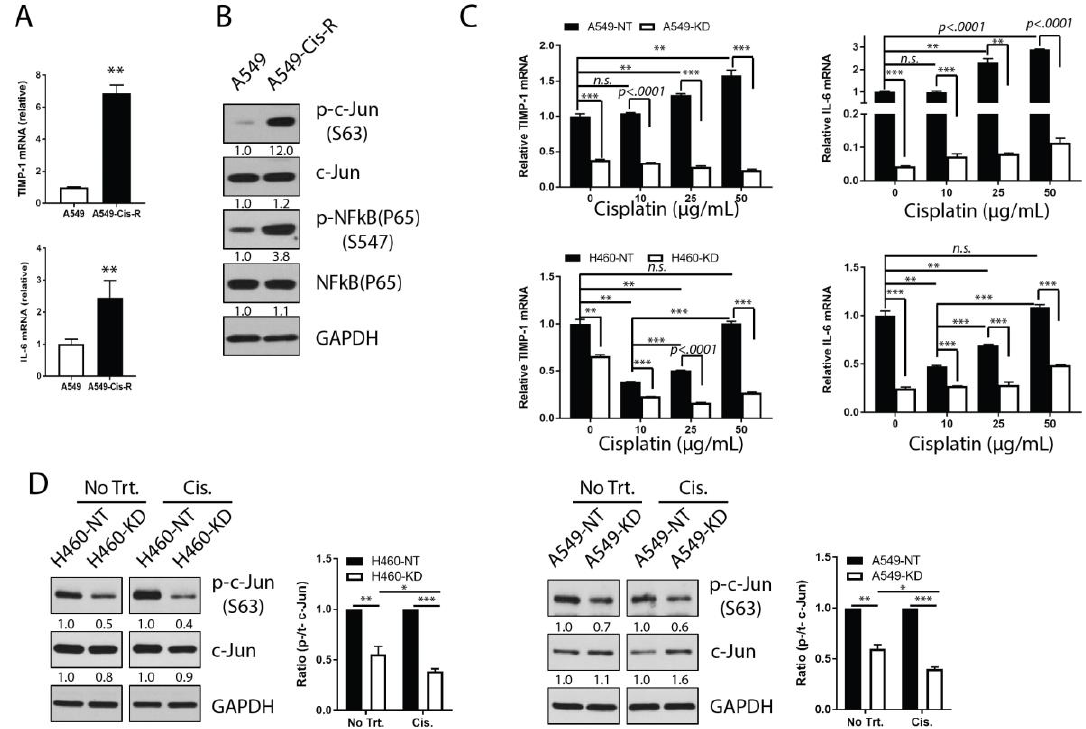
Figure 5. NSCLC cells increased their tolerance to two frontline chemotherapy drugs via upregulation of TIMP-1 and IL-6. Cisplatin-resistant A549 cells (A549-Cis-R) were established by treatment with gradient doses of Cisplatin and finally maintained in complete medium supplemented with 15 µg/mL of Cisplatin. ( A ) Whole cell lysates from parental A549- and A549-Cis-R as well as TIMP-1 and IL-6 mRNA were analyzed by RT-PCR. ( B ) Whole-cell lysates were analyzed for transcription signaling, as indicated by immunoblotting. GAPDH was the reference loading control. ( C ) A549- or H460-derived shRNA-encoding cells (A549-NT, A549-KD, H460-NT, and H460-KD) were treated with Cisplatin at different doses as indicated for 72 hours. TIMP-1 and IL-6 mRNA expression was measured by qRT-PCR. ( D ) The above cells were treated with Cisplatin for one hour. The response of AP-1 transcriptional signal was detected by immunoblotting. The band intensity of the relevant protein was normalized to that of the reference gene by the ImageJ program. The relative ratios of phosphorylated signal to total signal are presented. Statistical significance is denoted as follows: * p < 0.05; ** p < 0.01; *** p < 0.001